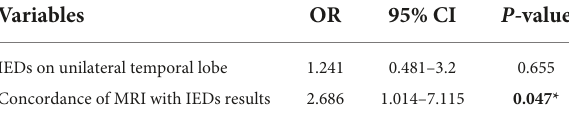
TABLE 4 Predictors of seizure outcome in adults on multivariate